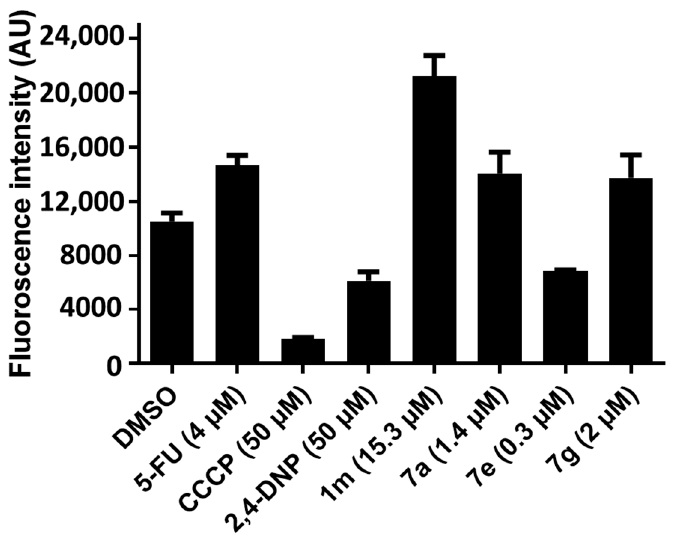
Figure 3. Evaluation of 1l on the mitochondrial membrane potential of Ramos cells. The asterisks indicate a statistically significant difference ( p < 0.05) from solvent-treated (DMSO) cells.